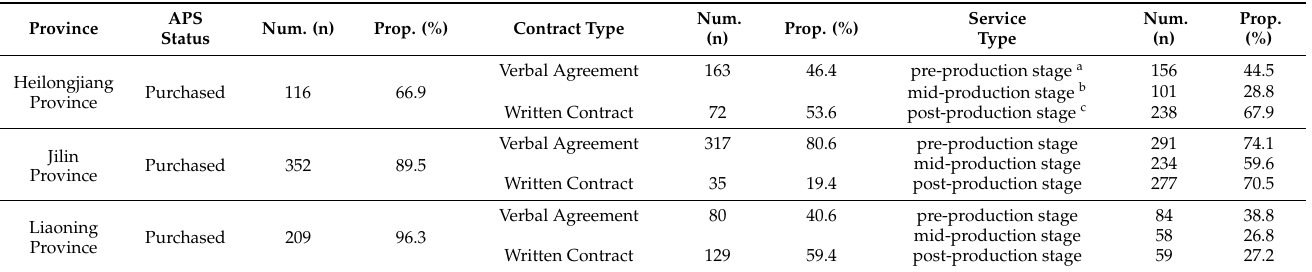
Table 3. Participation of interviewed farmers in